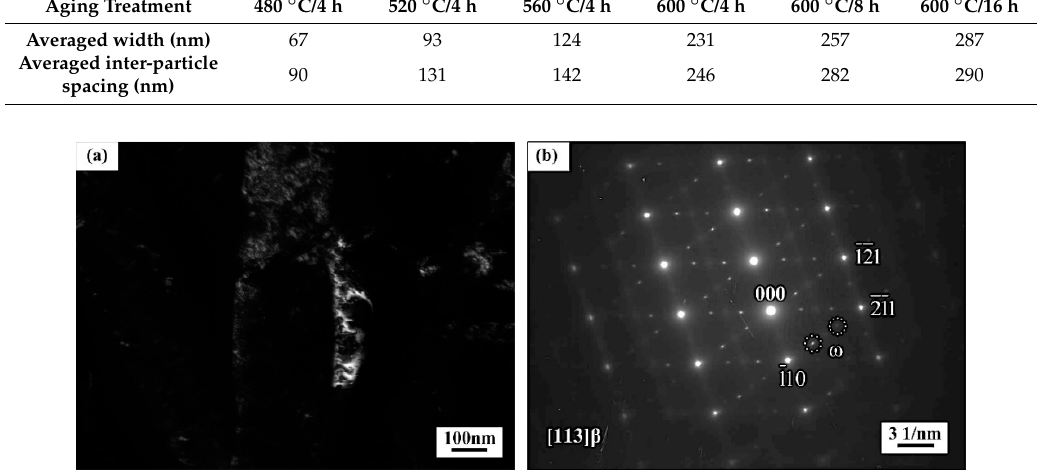
Figure 8. ( a ) Dark-field TEM micrograph of the as-quenched alloy; ( b ) corresponding electron diffraction patterns of β matrix. Table 1. Averaged width and inter-particle spacing of intragranular α after aging treatments.